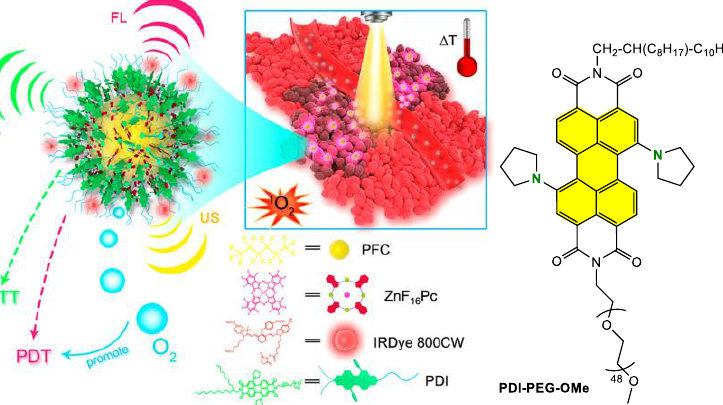
Figure 22 . Photoacoustic nanodroplet PS-PDI-PAnD for in vivo photothermal and photodynamic therapies. Reprinted with permission from reference [133]. Copyright 2018 American Chemical Society.